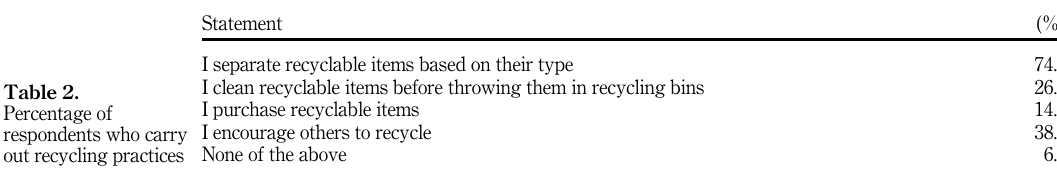
Table 2. Percentage of respondents who carry out recycling